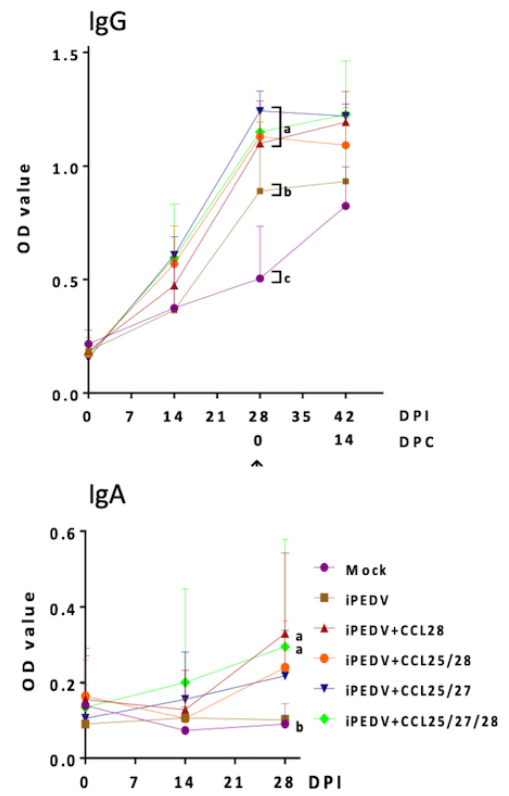
Figure 4. The detection of systemic PEDV spike (S)-specific IgG and fecal IgA in piglets. The PEDV-specific IgG in blood was detected at 0, 14, and 28 days post-immunization (DPI) and at 14 days post-challenge (DPC) following the challenge with the virulent PEDV, PEDVPT-P6 and 7. The mucosal PEDV-specific fecal IgA was detected in piglets at 0, 14, and 28 DPI. Data is displayed as the average optical density (OD) values of each group with error bars representing the standard deviation (SD). The arrow reflects the particular time (28 DPI or 0 DPC) of the PEDVPT-P6 and 7 challenge. Statistically significant differences are present among a, b, and c ( p < 0.05).